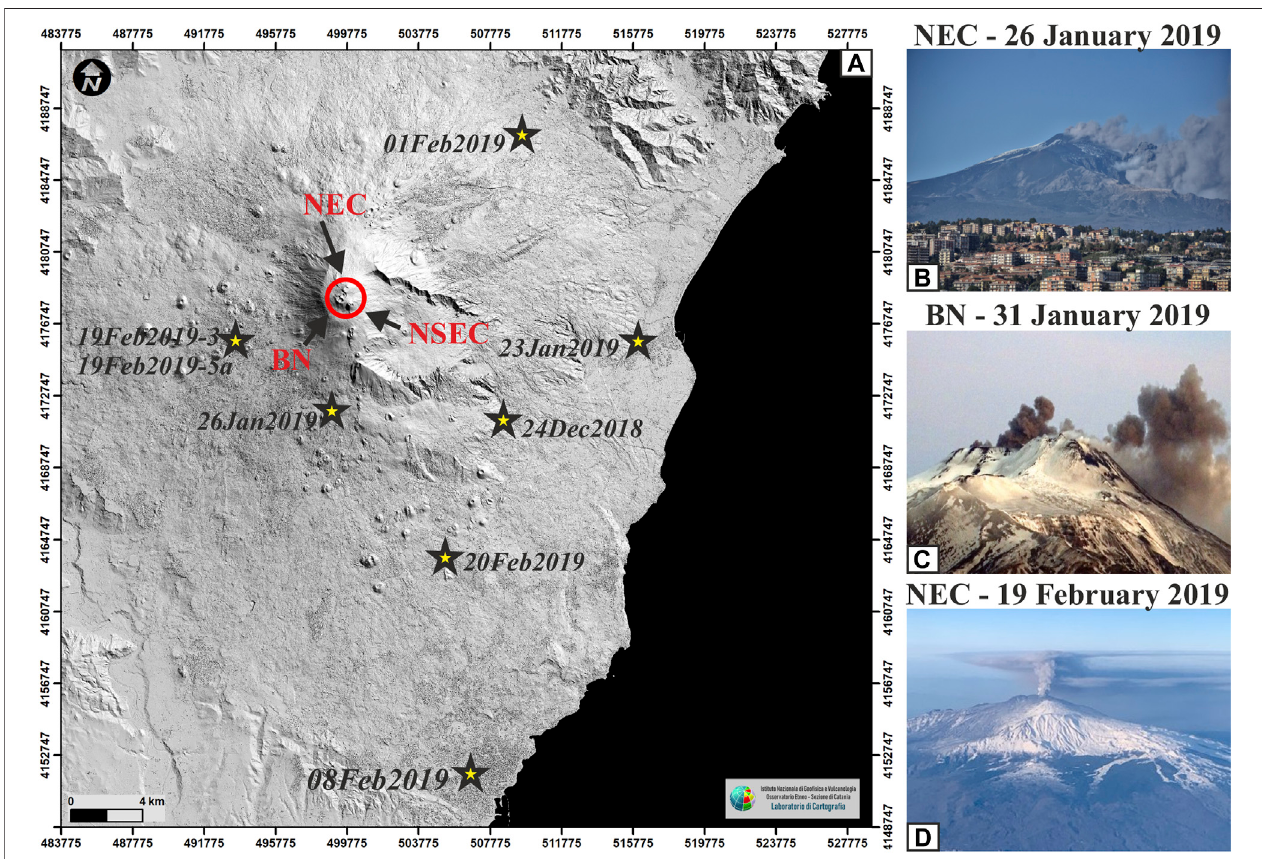
FIGURE 1 | (A) DEM (digital elevation model; modi fi ed after Gwinner et al., 2006) of Mt. Etna volcano with active vents (red circle). STARS correspond to sampling sites; (B – D) representative pictures of the studied activity at NEC (B,D) and BN (C) . NEC = Northeast Crater; BN = Bocca Nuova; NSEC = New Southeast